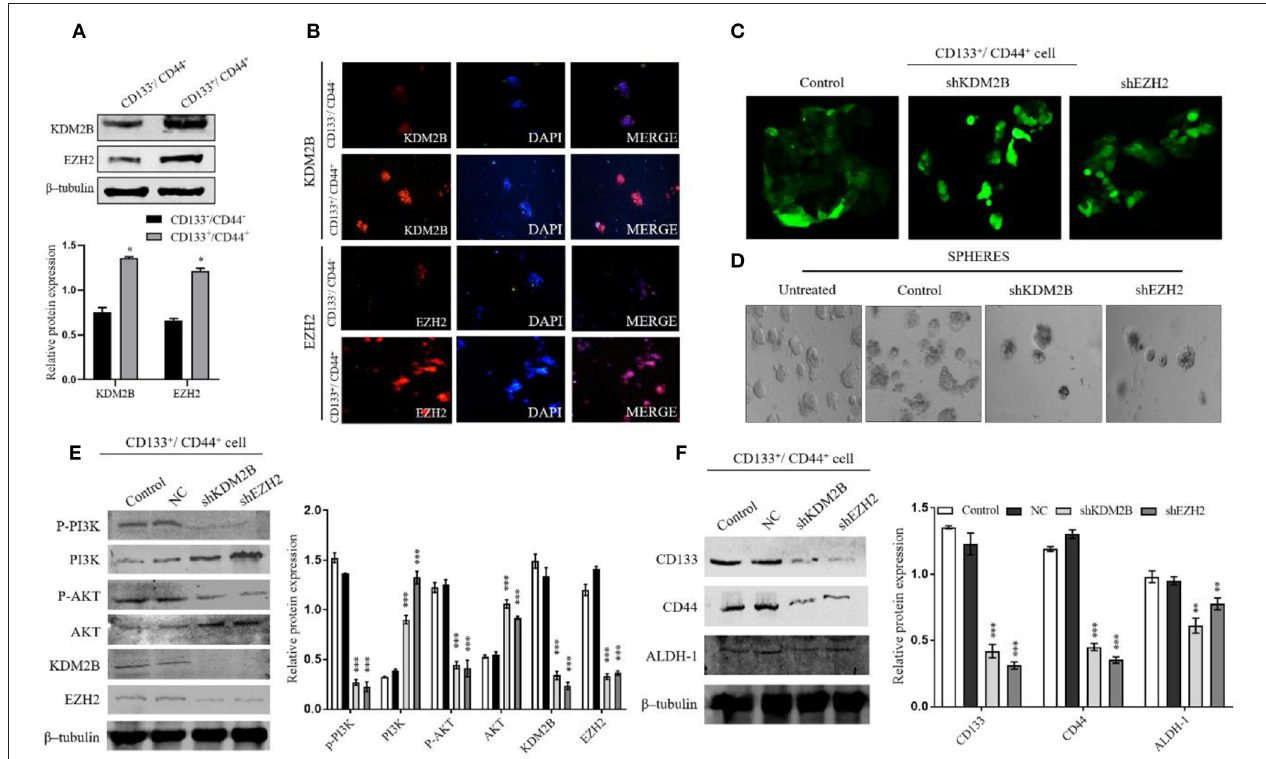
FIGURE 5 | KDM2B and EZH2 were indispensable for CCS-like cell maintenance in vitro via regulating the PI3K/AKT pathway. The CRC cancer stem cell population (CD133 − /CD144 − and CD133 + /CD144 + ) were isolated from HT-29 cells by MACS. (A) Protein expression levels of KDM2B and EZH2 confirmed in CD133 − /CD144 − and CD133 + /CD144 + cells by Western blot. The cluster bar chart represents the Western blot quantification (A) * p < 0.05. (B) Immunofluorescence staining of KDM2B and EZH2 in CD133 − /CD144 − and CD133 + /CD144 + cells (Scale bar: 100 µ m). (C) CD133 + /CD144 + cells were transfected via the lentiviral expression vector of short hairpin RNA (shRNA) against KDM2B and EZH2 (shKDM2B and shEZH2) and negative control, and more than 70% of cells had green fluorescence under the fluorescence microscope. Representative microscopic images were taken. (D) Sphere formation in untreated, control, shKDM2B, and shEZH2 groups. The expansion of tumor spheres was analyzed at 40 × magnification under a microscope (bar = 50 µ m; magnification, 400 × ). The knockdown of KDM2B and EZH2 activated the PI3K/AKT pathway in the stem cell population in CRC. (E) The expression of p-PI3K, PI3K, p-AKT, AKT, KDM2B, and EZH2 was analyzed by Western blot Assay after KDM2B and EZH2 knockdown in CD133 + /CD44 + cell population. β -tubulin was used as a loading control. (F) The downregulation of KDM2B and EZH2 weakens self-renewal markers in CRC cells. The assessment of protein expression of stemness markers including CD44, CD133, and ALDH-1 was analyzed by Western blotting. The data was statistically significant at ** p < 0.01, *** p < 0.001 as compared to the control. Data are represented as mean ± SEM of three independent